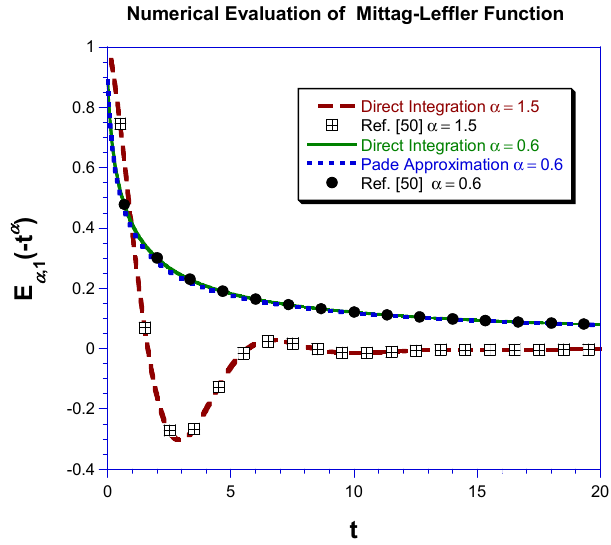
Figure 3. Comparing the Mittag-Leffler function (MLF) calculated by different methods: Equation (33) from the direct integration method, the Pade approximation method [50], and the method used in [49].